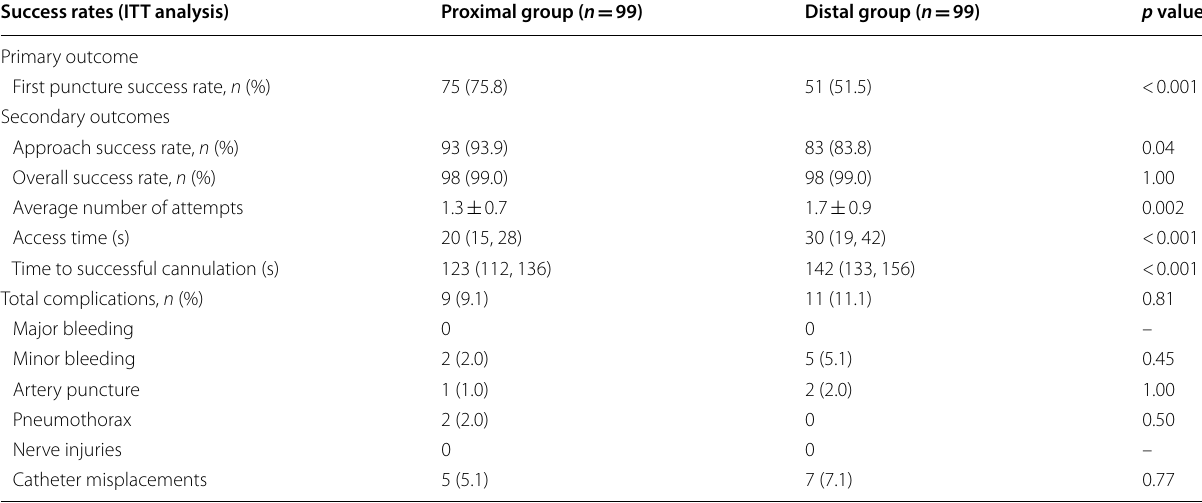
Continuous data are presented as the mean (SD) or median (IQR). Categorical data are presented as counts (%)